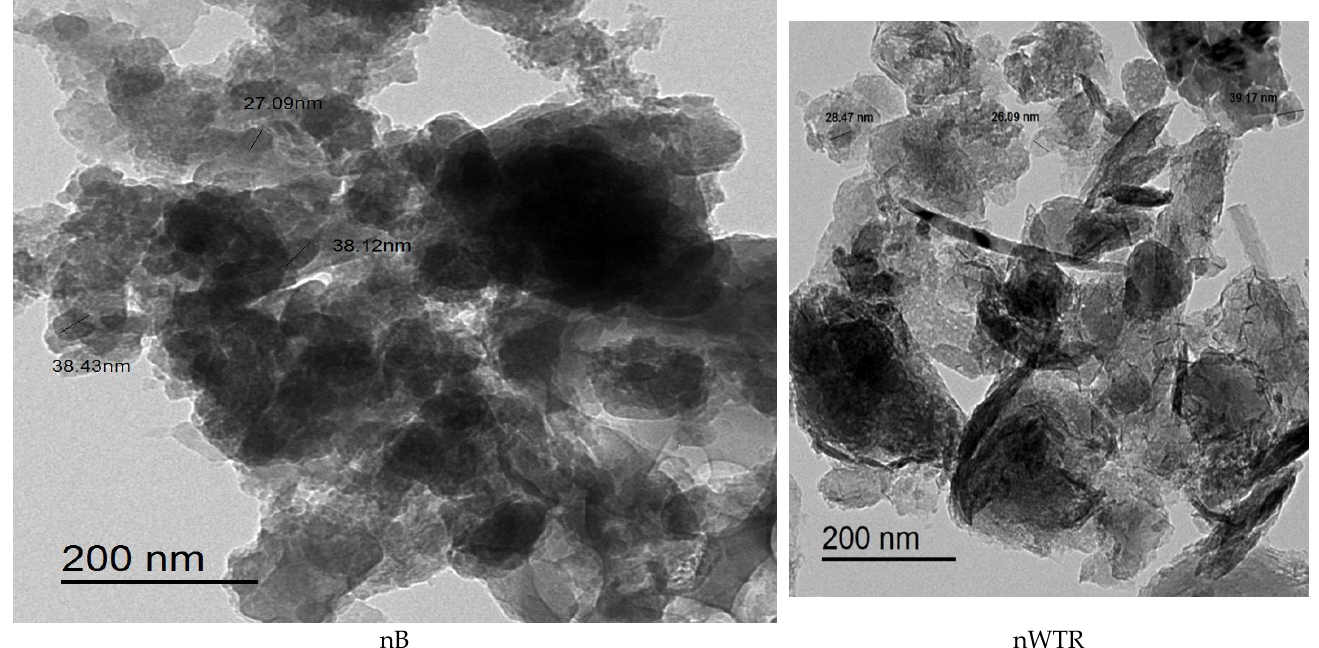
Figure 2. Transmission electron microscope (TEM) image for nanobiochar (nB) and nanowater treatment residuals (nWTR).